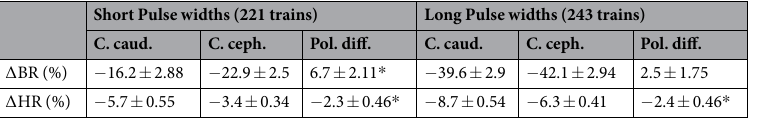
Table 2. Similar to Table 1, but this time for trains of stimuli with short pulse widths, between 60 and 100 μ s, and with long pulse widths, above 240 μ s. Responses observed with pulse widths 100 μ s or shorter were similar to each other; responses with pulse widths 240 μ s or longer were similar to each other. Therefore, pulse widths were categorized in one of 2 groups: either short ( <= 100 μ s) or long ( >= 240 μ s).